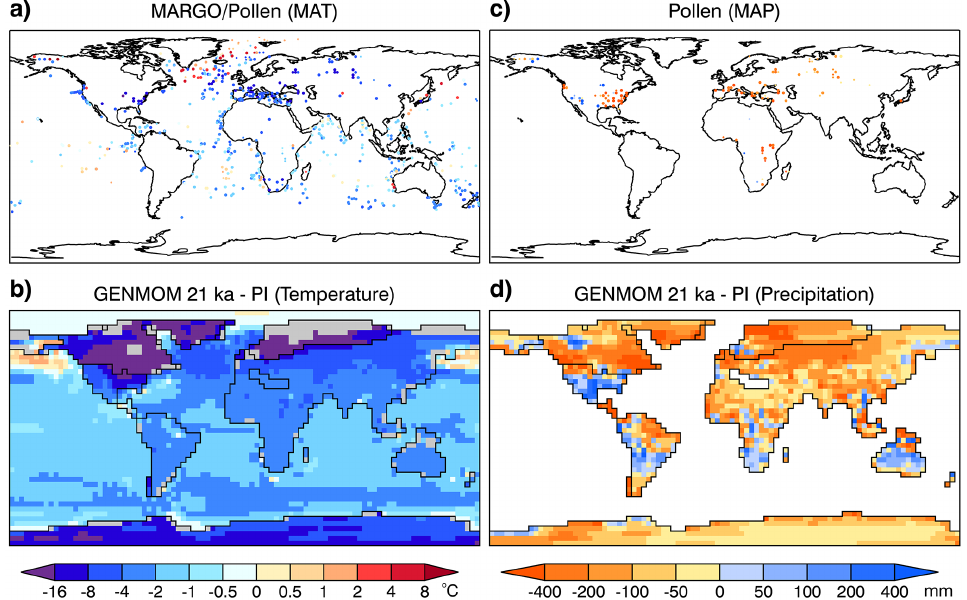
Figure 14. Changes in 21ka mean annual temperature (MAT) and precipitation (MAP) inferred from data and simulated by GENMOM. (a) Blended sea surface temperature from MARGO (Waelbroeck et al., 2009) and terrestrial temperature from Bartlein et al. (2011), (b) GENMOM temperature anomalies (blended sea surface temperature and 2m air temperature over land), (c) precipitation from Bartlein et al. (2011), and (d) GENMOM precipitation anomalies. Grid cells with different land mask types in the 21ka and PI simulation are shaded in gray to avoid comparing ocean temperature to land temperature in emergent